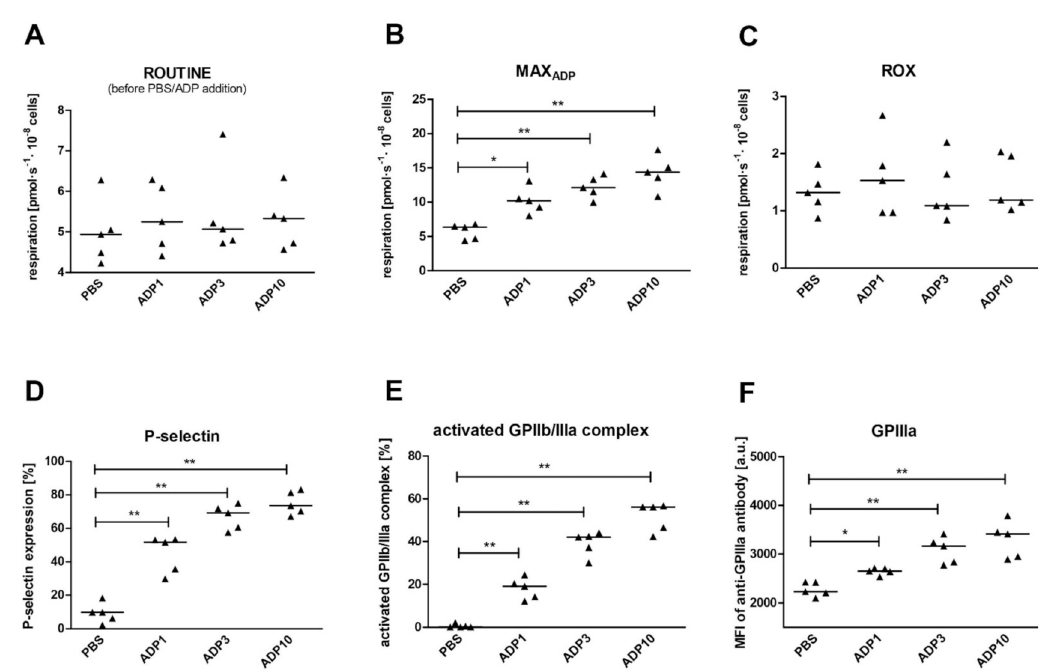
Figure 5. Oxygen consumption and cytometric markers of platelet activation in blood platelets stimulated with ADP. Data presented as individual data points with medians (horizontal lines); n = 5 for ROUTINE respiration before PBS or ADP addition measured in four different chambers of an oxygraph ( A ), maximal oxygen consumption after ADP addition ( B ), non-mitochondrial respiration ( C ), percentage of P-selectin-positive platelets ( D ), GPIIb/IIIa (activated complex)-positive platelets ( E ), and MFI of GPIIIa-bound antibodies ( F ) in resting (PBS) and ADP-activated platelets. Three ADP concentrations (1, 2, and 10 µ M) were tested compared to the control. The significance of differences, as estimated with Friedman’s ANOVA ( A ) or ANOVA for repeated measures with Dunnett’s post hoc test ( B – F ), was: * p < 0.01, ** p < 0.001.